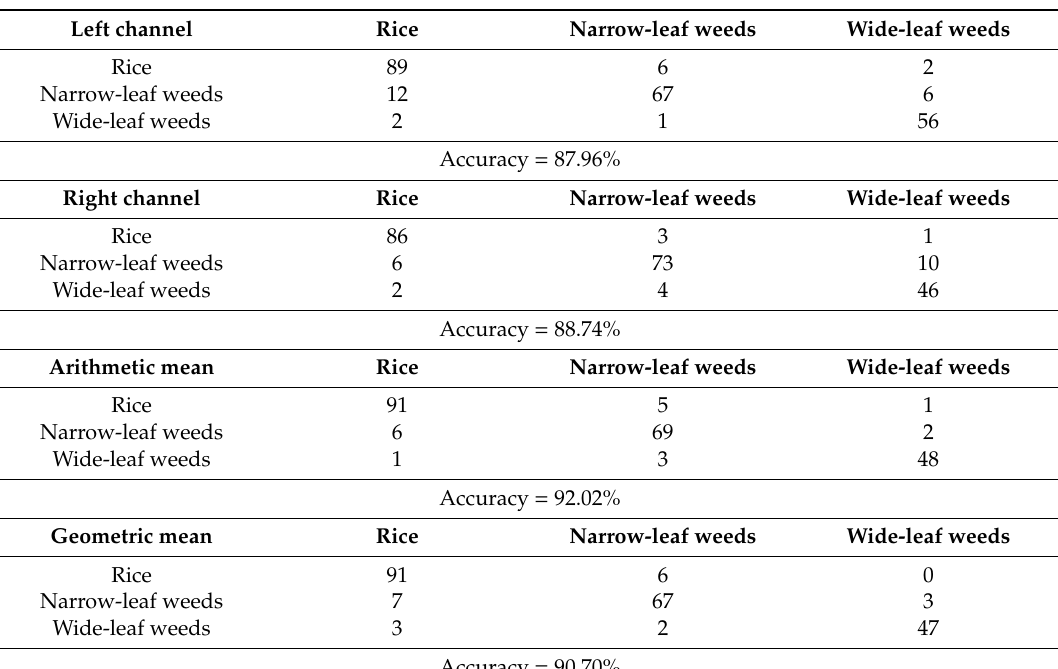
Table 5. Confusion matrices and accuracy of the ANN-BA classifier for the left channel, right channel, arithmetic mean, and geometric mean (test